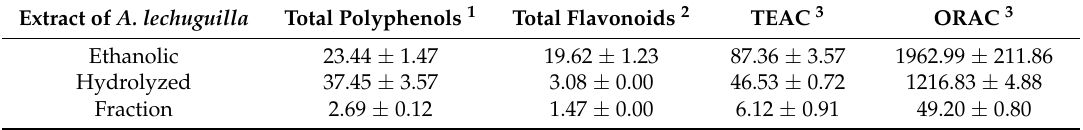
Table 1. Concentrations of total polyphenols, total flavonoids and antioxidant capacity. Extract of A.